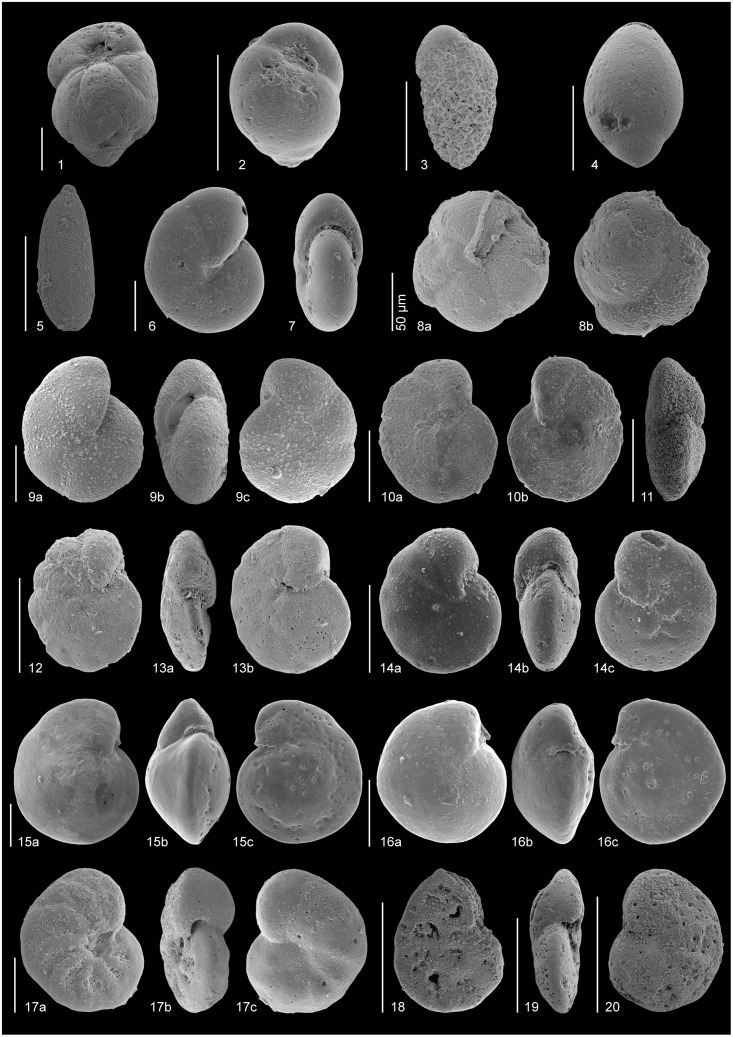
SEM images of some common Ypresian (lower Eocene) species.All scale bars represent 100 μm, unless otherwise indicated. 1, Buliminella beaumonti (sample 1258-14-2, 76–78 cm). 2, Turrilina brevispira (sample 401-13-2, 75–76 cm). 3, Bolivina huneri (sample 401-13-4, 130–132 cm). 4–5, Polymorphinids: 4, Ellipsoglandulina sp. (sample 1258-14-3, 104–106 cm), 5, Pyrulinoides acuminatus (sample 401-13-1, 125–126 cm). 6, Nonion havanense (sample 401-13-2, 75–76 cm): lateral. 7, Nonion havanense (sample 401-13-2, 75–76 cm): apertural. 8, Alabaminella weddellensis (sample 401-13-4, 130–132 cm): a) ventral, b) dorsal. 9, Clinapertina inflata (sample 865-10-2, 60–62 cm): a) ventral, b) apertural, c) dorsal. 10, Cibicidoides micrus (sample 550-29-5, 115–117 cm): a) dorsal, b) ventral. 11, Cibicidoides micrus (sample 550-29-6, 2–4 cm): apertural. 12, Cibicidoides ungerianus (sample 401-13-1, 88.5–90 cm): ventral. 13, Cibicidoides ungerianus (sample 401-13-2, 130–132 cm): a) apertural, b) dorsal. 14, Anomalinoides cf. acutus (sample 690C-15-3, 16–18 cm): a) ventral, b) apertural, c) dorsal. 15, Cibicidoides eocaenus perlucidus (sample 550-29-5, 95–97 cm): a) umbilical, b) apertural, c) dorsal. 16, Cibicidoides eocaenus tuxpamensis (sample 550-29-1, 110–112 cm): a) umbilical, b) apertural, c) dorsal. 17, Hanzawaia ammophila (sample 865-10-3, 60–62 cm): a) ventral, b) apertural, c) dorsal. 18, Hanzawaia mantaensis (sample 1051-48-1, 37–39 cm): dorsal. 19, Hanzawaia mantaensis (sample 1051-48-2, 75–77 cm): apertural. 20, Hanzawaia mantaensis (sample 1051-48-2, 75–77 cm): ventral.